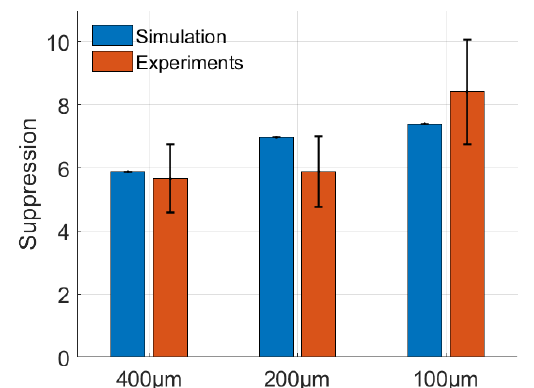
Figure 9. Comparison of the suppression factors obtained by simulations and experiments. The average and standard deviation of the experimental suppression factor for each MMF is calculated over 15 measurements.